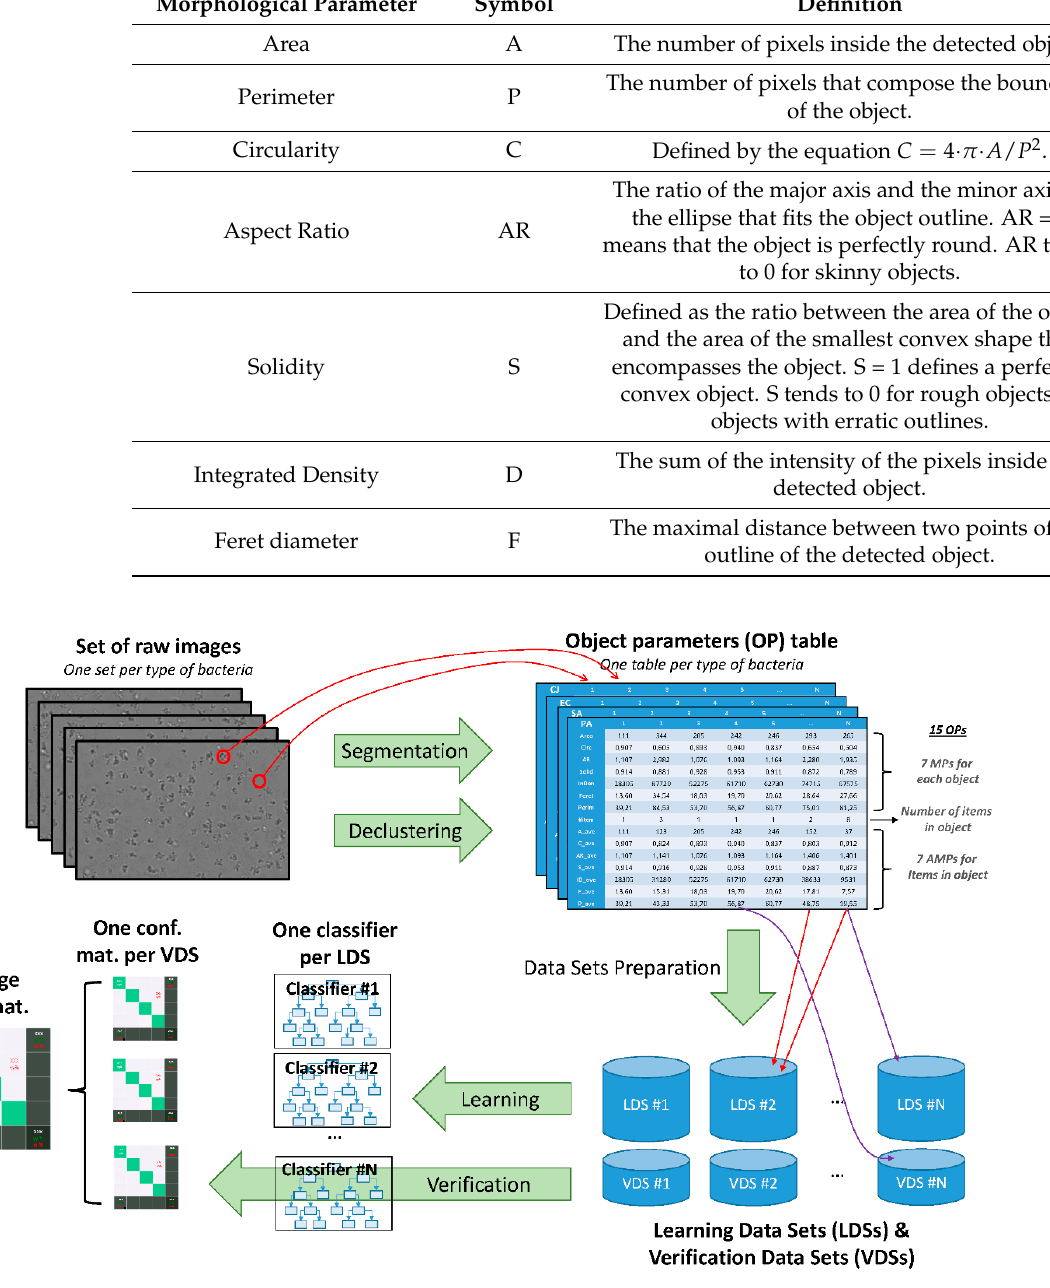
Figure 1. Description of the complete workflow. First, a set of images is acquired for each type of bacteria. Second, image-processing algorithms, namely the segmentation and the declustering are applied on images in order to obtain a table of parameters for each type of bacteria. The segmentation provides the seven morphological parameters (MPs) while the declustering provides the number of items in each object and the seven average morphological parameters (AMPs). Third, N learning datasets (LDSs) are prepared by picking randomly a same number of columns in each table. N verification datasets (VDSs) are prepared by the same way. There are about three times more objects in the LDS than in the VDS. A same column can be used for two different LDS, or for an LDS and another VDS but not for both an LDS and its associated VDS. Fourth, machine-learning algorithms are applied on each LDS to obtain N classifiers. Fifth, classifiers are applied to the corresponding VDS to compute the N confusion matrices. Results shown in the paper correspond to the average result over the N dataset.